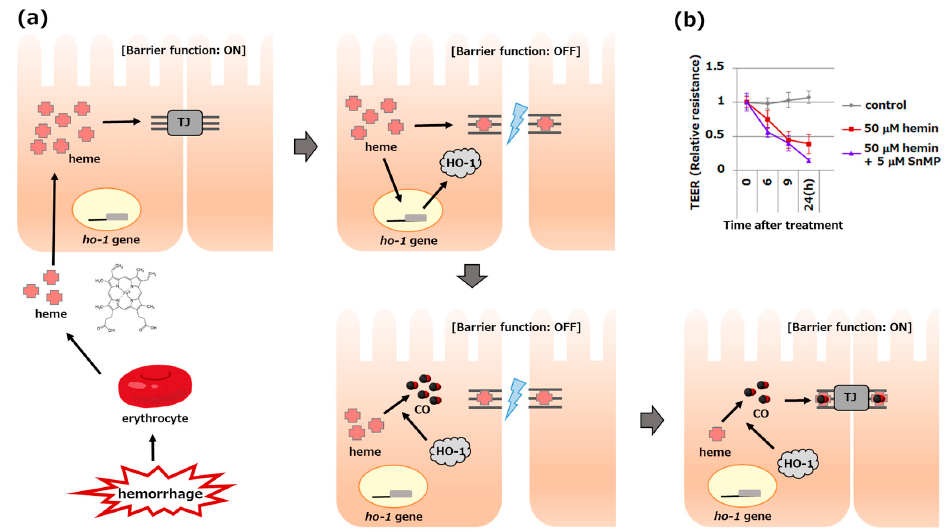
Figure 2. Possible role of HO-1 in protecting the barrier function of intestinal epithelial cells. ( a ) Free heme released from erythroids after intestinal hemorrhage causes an increase in intracellular free heme, which binds to components of the tight junction (TJ) complex, resulting in barrier dysfunction. Intracellular free heme also induces HO-1, reduces the intracellular free heme concentration, and produces carbon monoxide (CO) as a heme metabolite. As CO has a high affinity for heme proteins, it binds to the components of TJ, closing the barrier again by changing the protein’s configuration. ( b ) Measuring the trans-epithelial electrical resistance (TEER) in an experimental model using Caco-2 cells showed that hemin treatment disrupted the barrier function, which was aggravated by HO inhibition by SnMP.